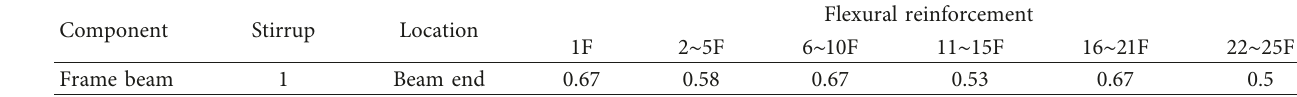
Table 7: Value of ρ